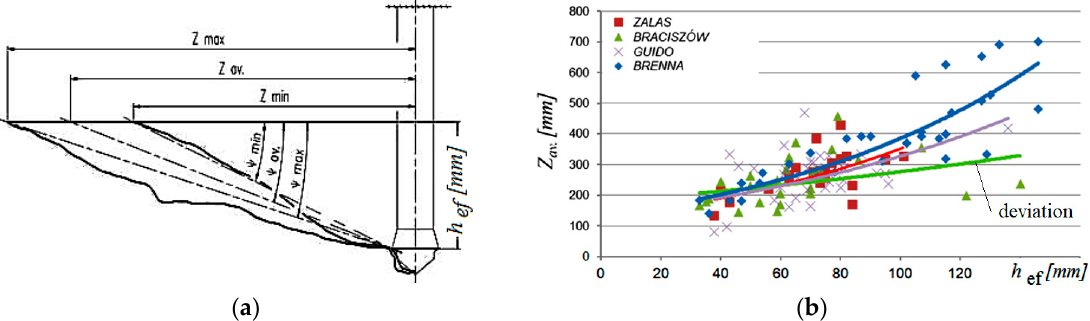
Figure 15. The average breakout cone angle ψ av ( a ) and crack length Z av ( b ) as functions of embedment depth h ef.